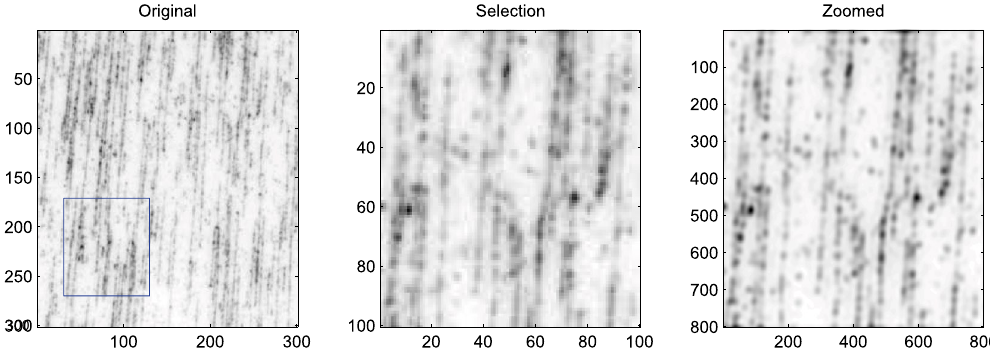
Figure 6. Single image super resolution of the DNA image obtained with a factor 8 up-sampling grid and a PSF FWHM of 400 nm. Left panel: the 300 × 300 observed image (field of view: 24 × 24 µ m labeled DNA fragments. Middle panel: the selected 100 by 100 pixel image. Right panel: super-resolution with a factor 8.